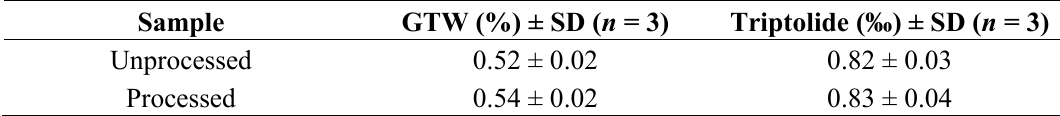
Table 2. Contents of GTW and triptolide in unprocessed and processed samples.